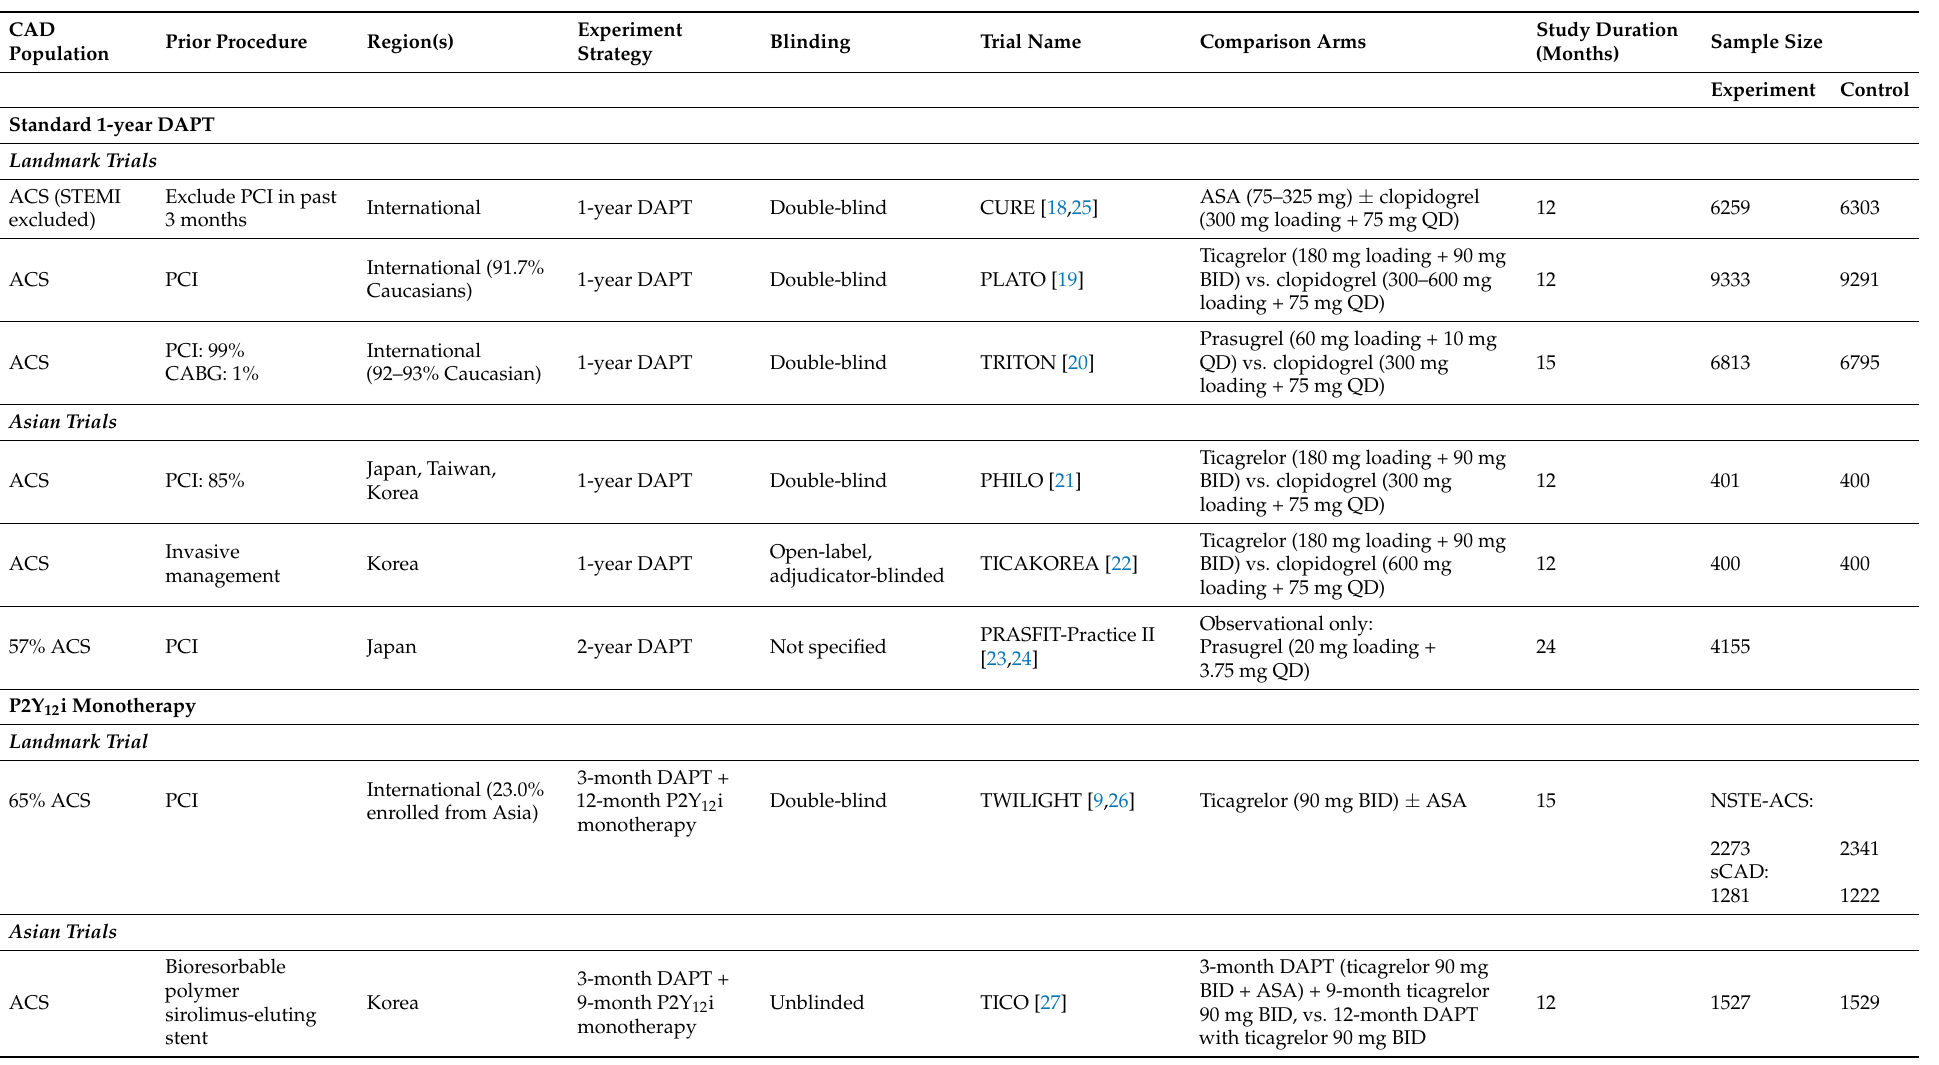
Table 2. Study designs of major international and Asian randomized controlled trials investigating the efficacy and safety of popular antiplatelet therapy